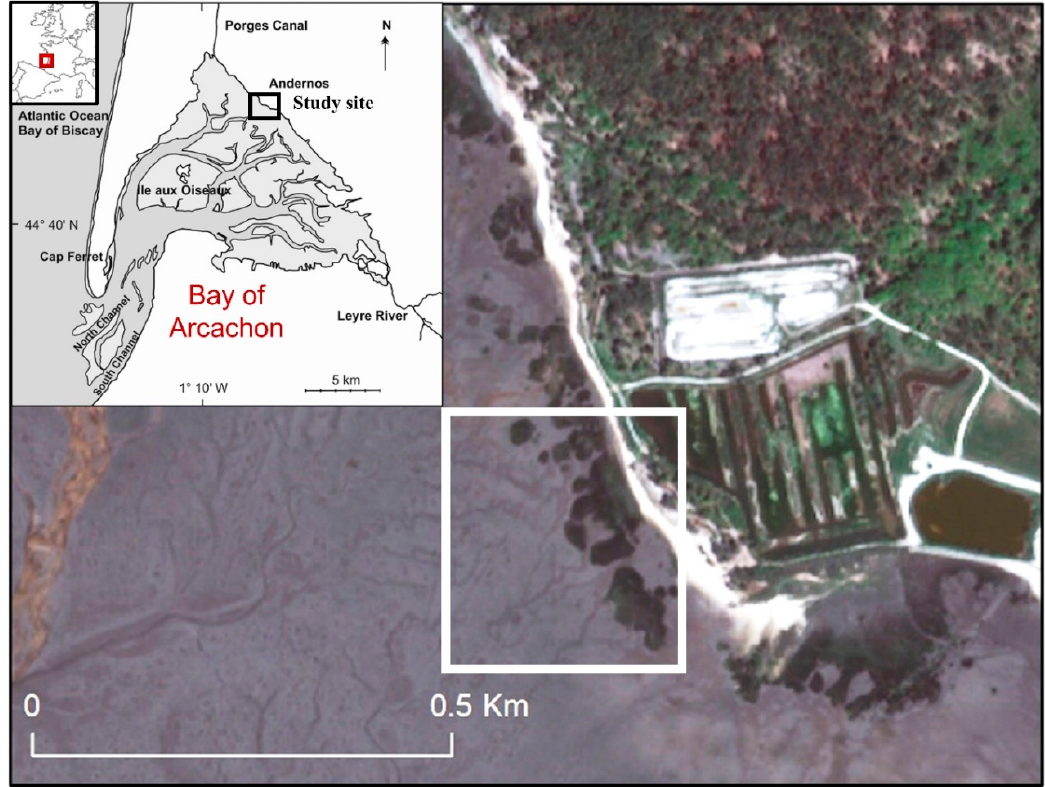
Figure 1. Location of the Andernos’ saltmarshes (white rectangle) in the study site (Bay of Arcachon, SW France).